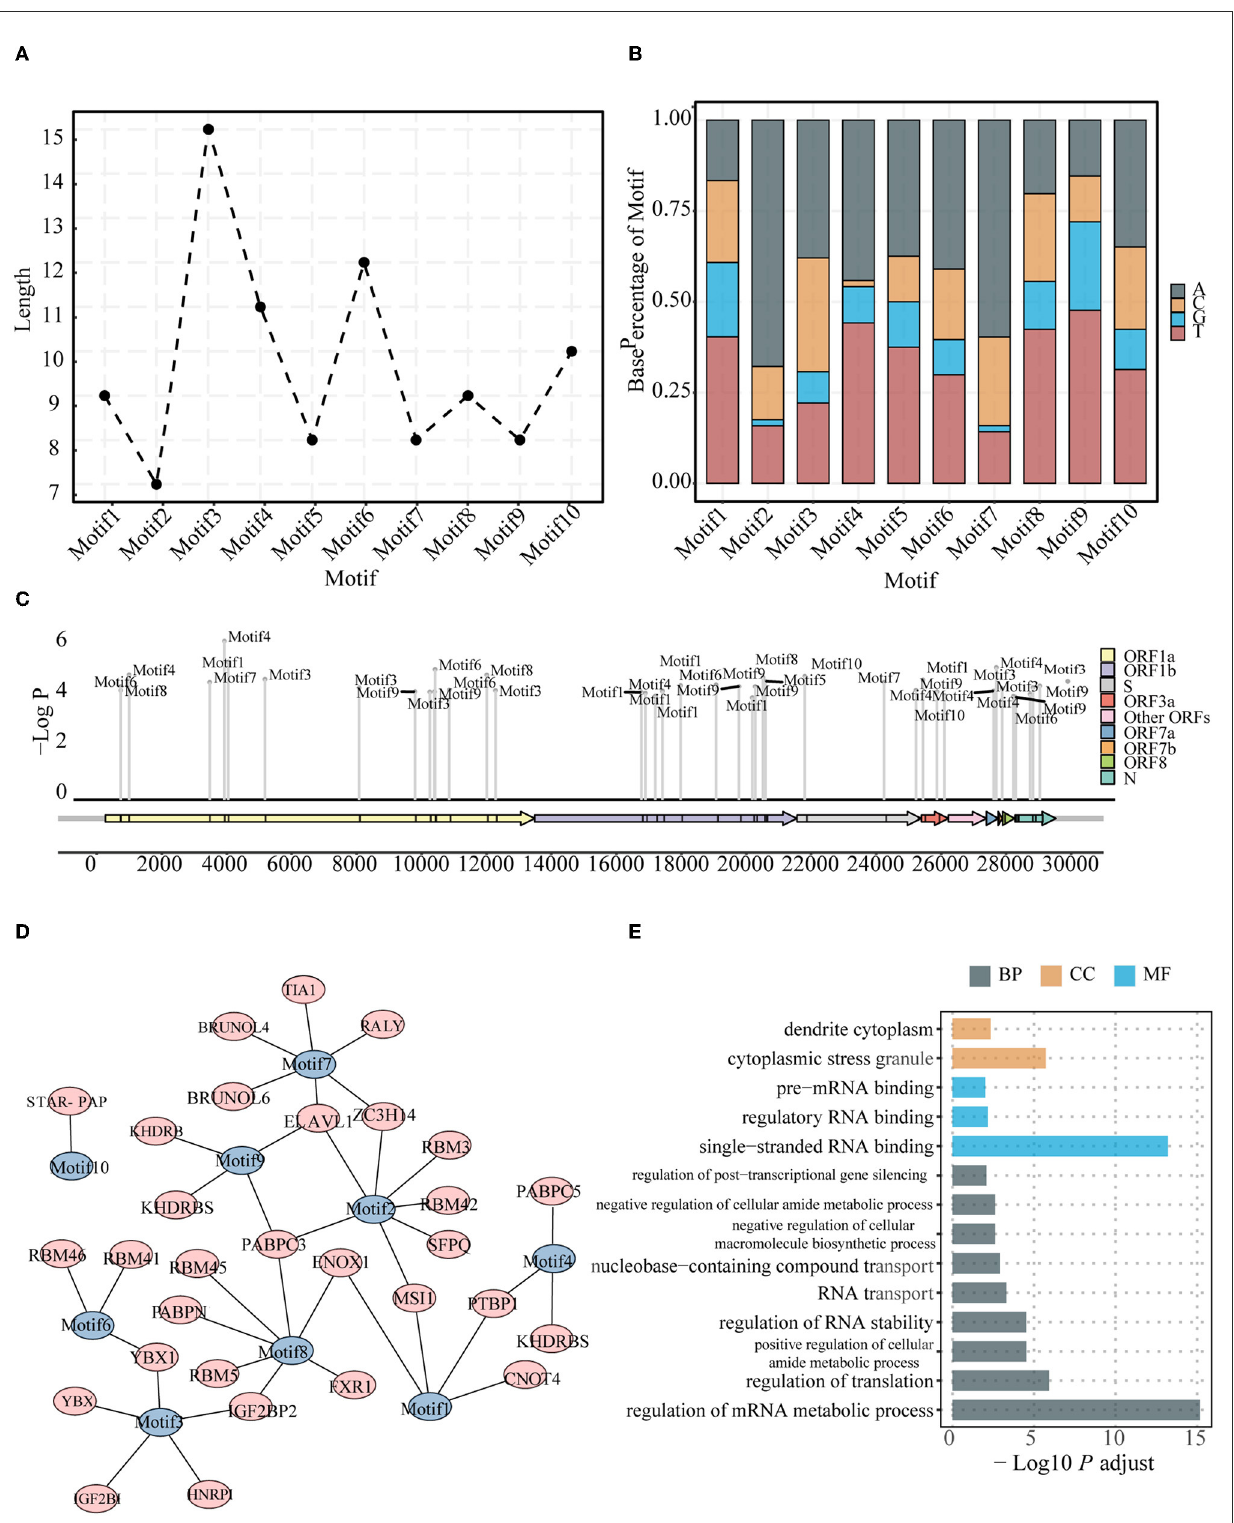
FIGURE2 Characteristics for the conserved motifs. Length (A) and Base composition (B) of identified motifs enriched in the constrained regions. The identification indexes are defined by sorting by P -value from the smallest to the largest. (C) Positions of identified motifs on the genome. The location of identified motifs was indicated by short black blocks in the ORFs. The vertical axis represents the credibility of the motif. (D) Motifs and related human RBPs. Motifs are colored in blue, and RBPs are colored in red. (E) GO terms enriched for motif-related human RBPs, including biological process, molecular function, and cellular